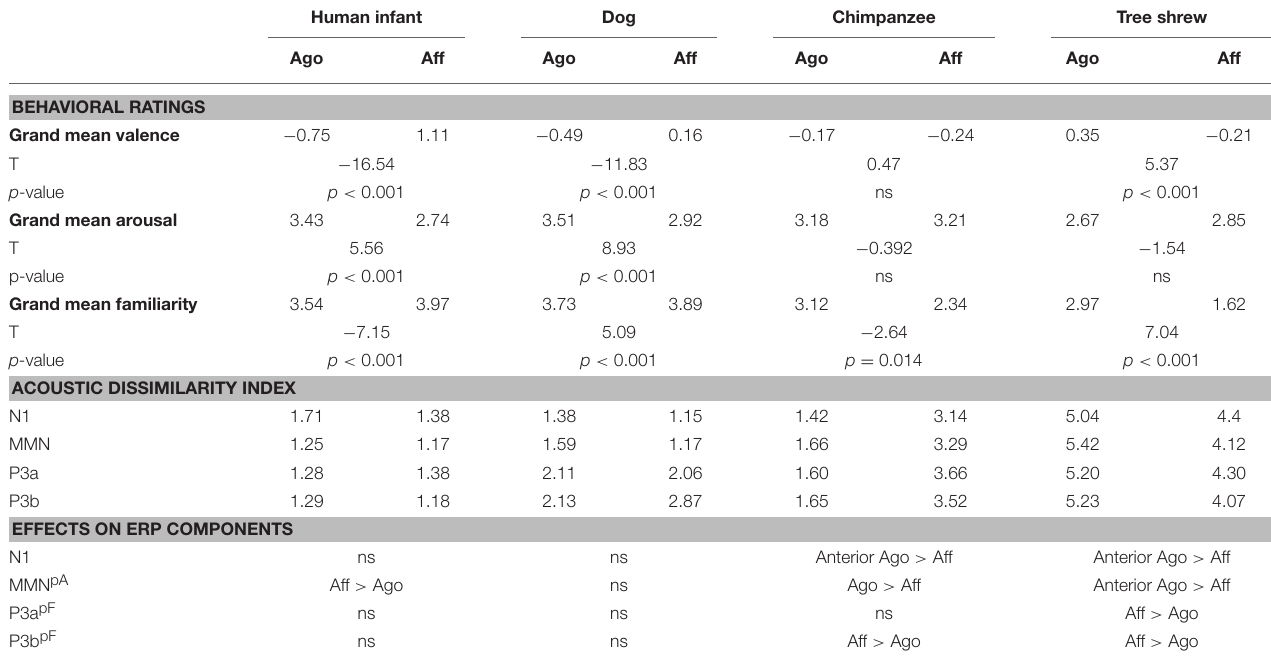
TABLE 1 | Results of the behavioral ratings ( = grand mean for valence, arousal, and familiarity as well as results of the t -test comparing the values between context categories), the acoustic dissimilarity index ( = Euclidian distance between standard and novel category based on the acoustic parameters per ERP time interval), and ERP effects ( = results of the statistical comparison between grand average amplitudes between context categories per species; Aff > Ago: affiliative voice elicits a larger negative or positive amplitude than agonistic voice and Ago > Aff vice versa; pA –correlation between grand average amplitude of the right posterior ROI with arousal; pF –correlation between grand average amplitude of the posterior ROIs with familiarity). Human infant Dog